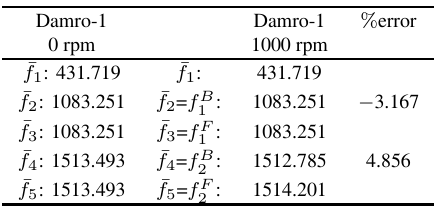
Table 10 Natural frequencies ¯ f k (Hz) of spindle-ball bear- ings assembly for Ω s = 0, 1000 rpm, bearing axial preload = 100 N, K cg =diag[K cg 11 K cg 22 K cg 33 K cg inc